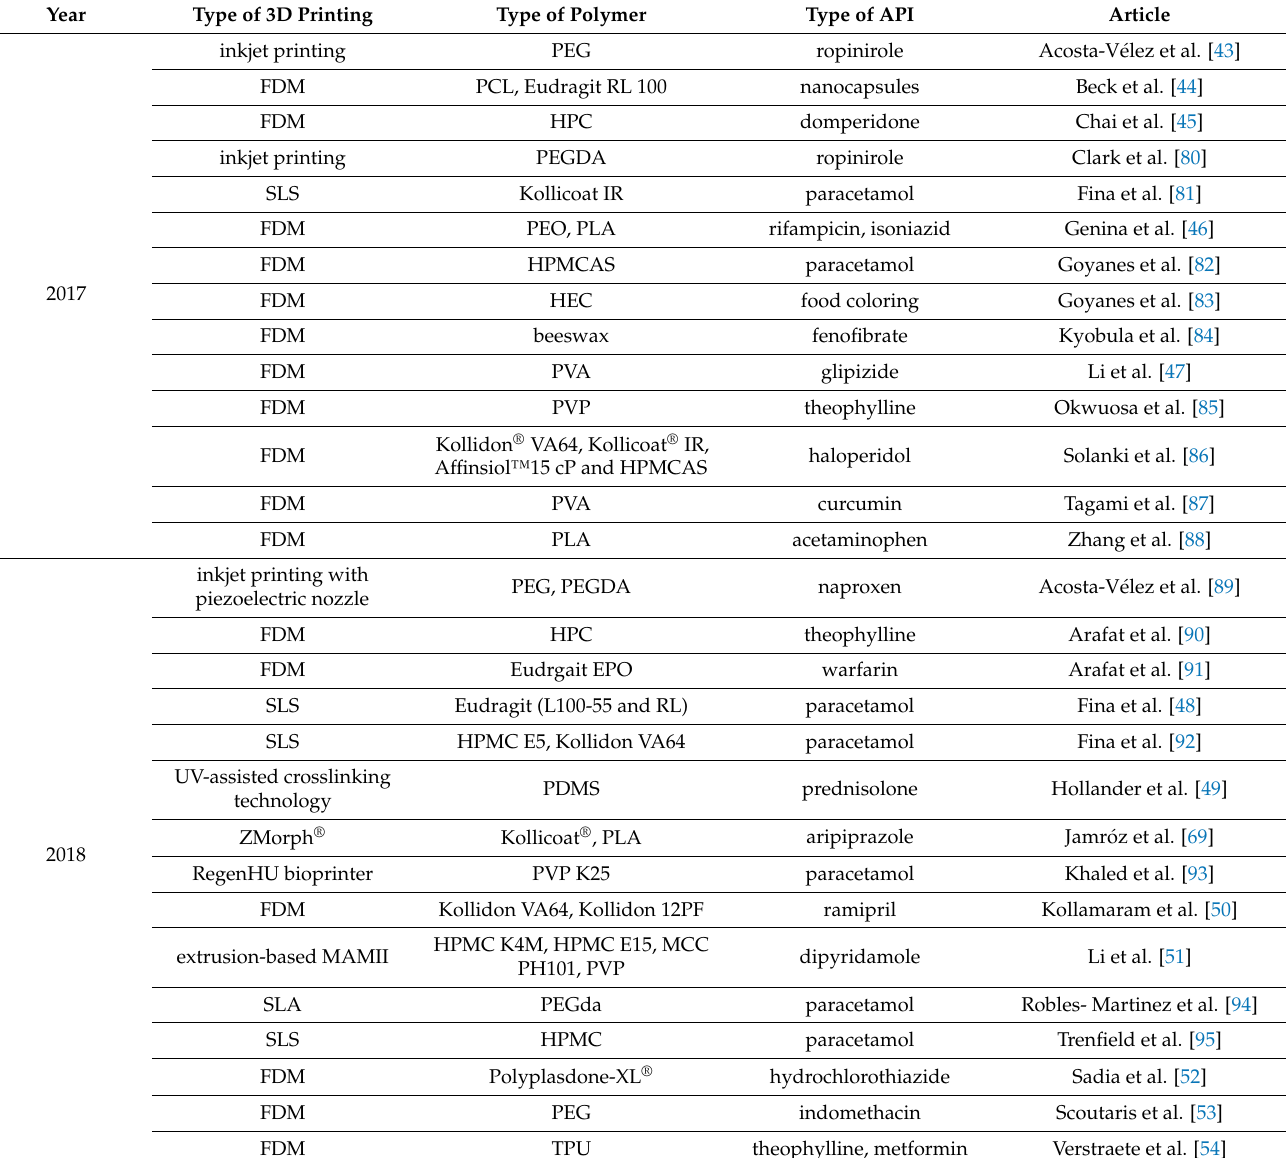
Table 2. The grouping of the manufactured tablets based on the publication year and then in alphabetical order between 2017 and